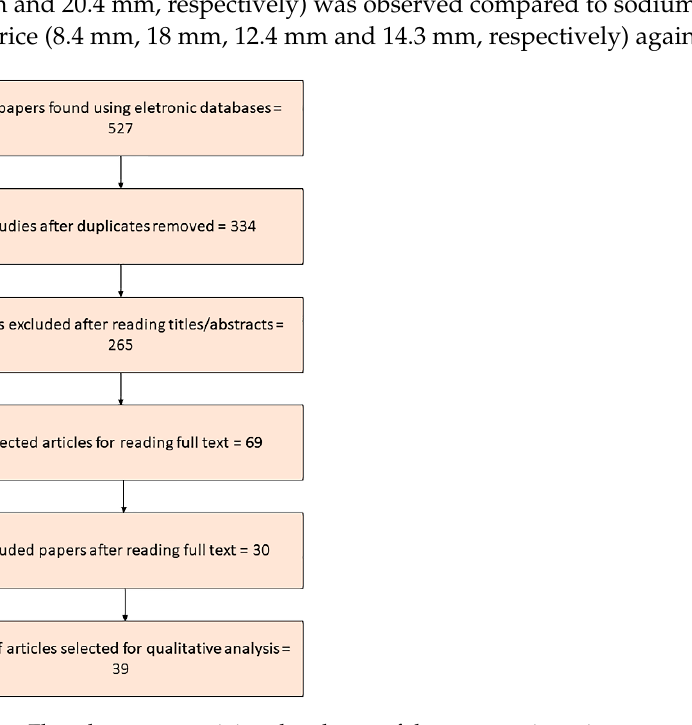
Figure 1. Flowchart summarizing the phases of the systematic review.